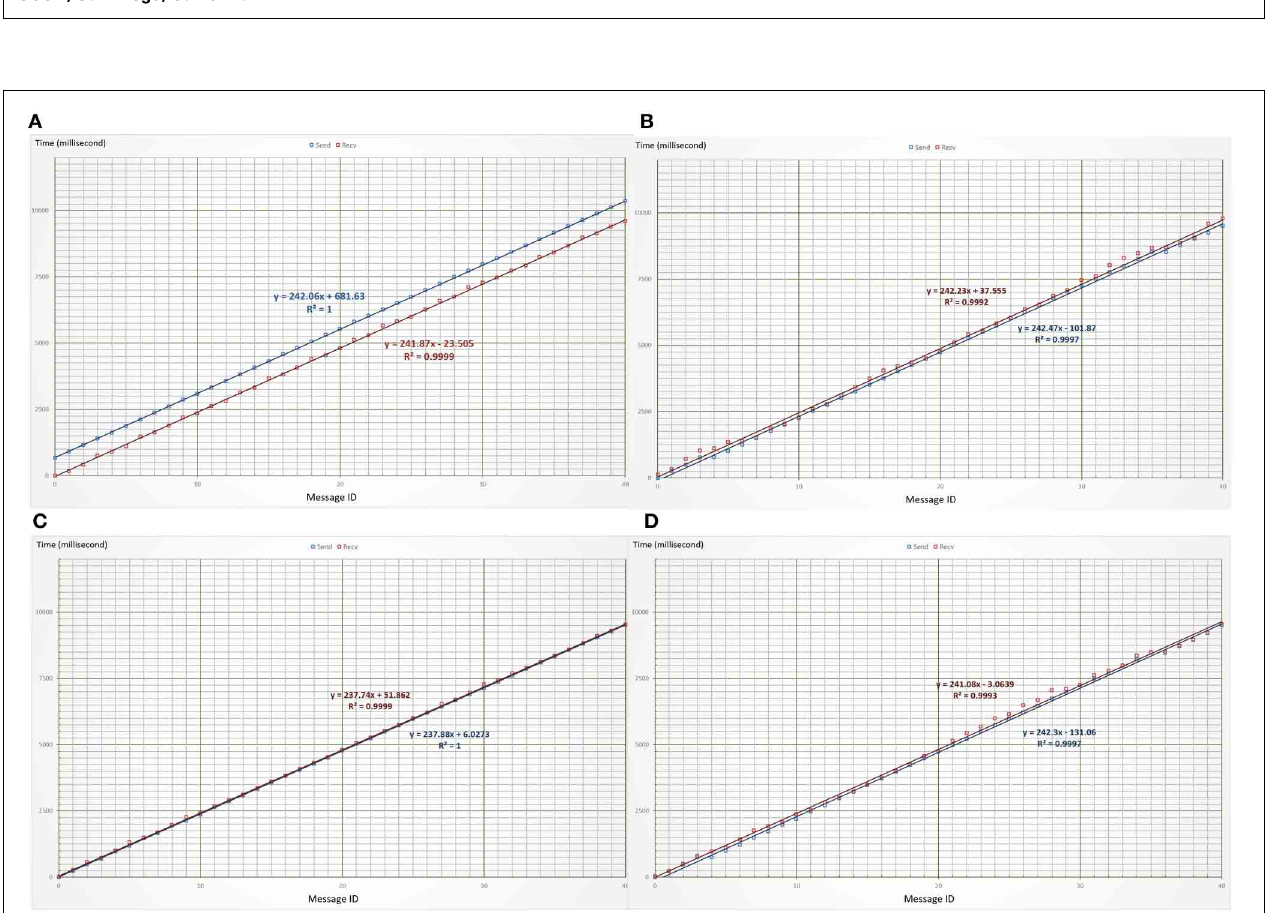
FIGURE 5 | Time traces of end-to-end synchronous transport of motion and EEG data streams. (A,B) show the time traces of motion and EEG data transports in two separate sessions. (C,D) show the traces of both transports